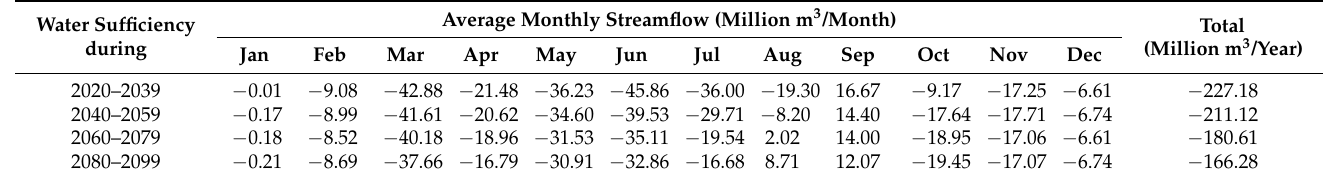
Table 8. Water sufficiency for agriculture in the Lam Takong River Basin under RCP